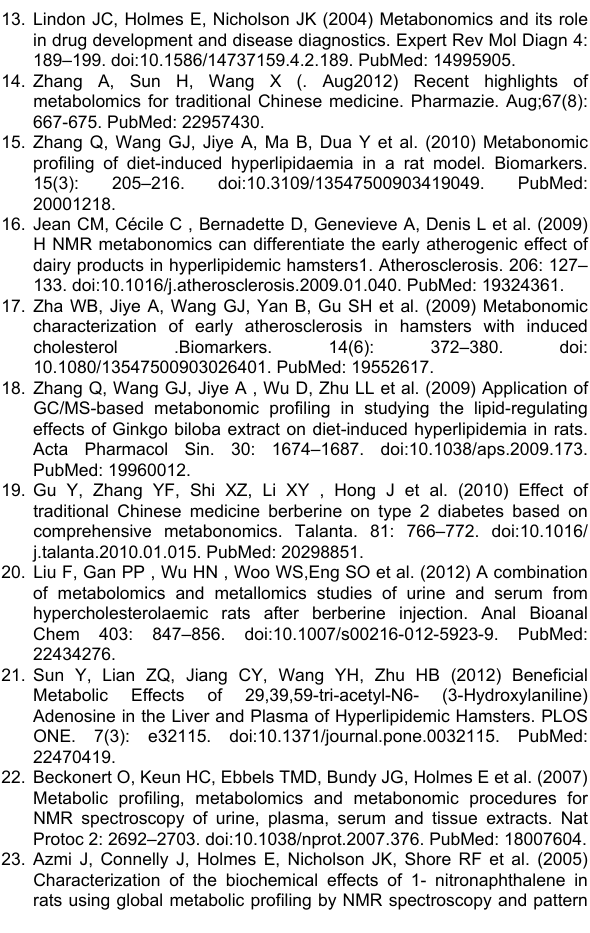
Table S3. Relative integrals from all metabolites except biomarkers in the liver of